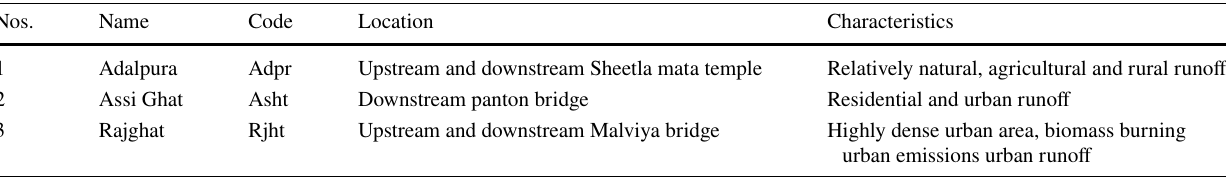
Table 1 Sampling sites and characteristics of sub-catchments